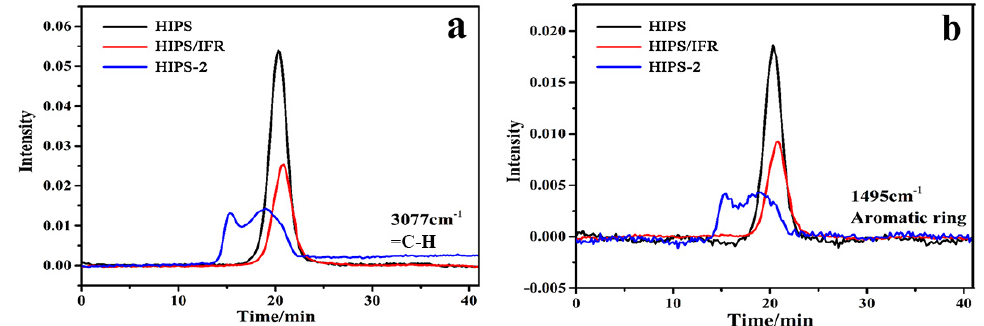
Figure 8. The absorbance of volatile products of the HIPS compounds: ( a ) =C-H; ( b ) aromatic ring.